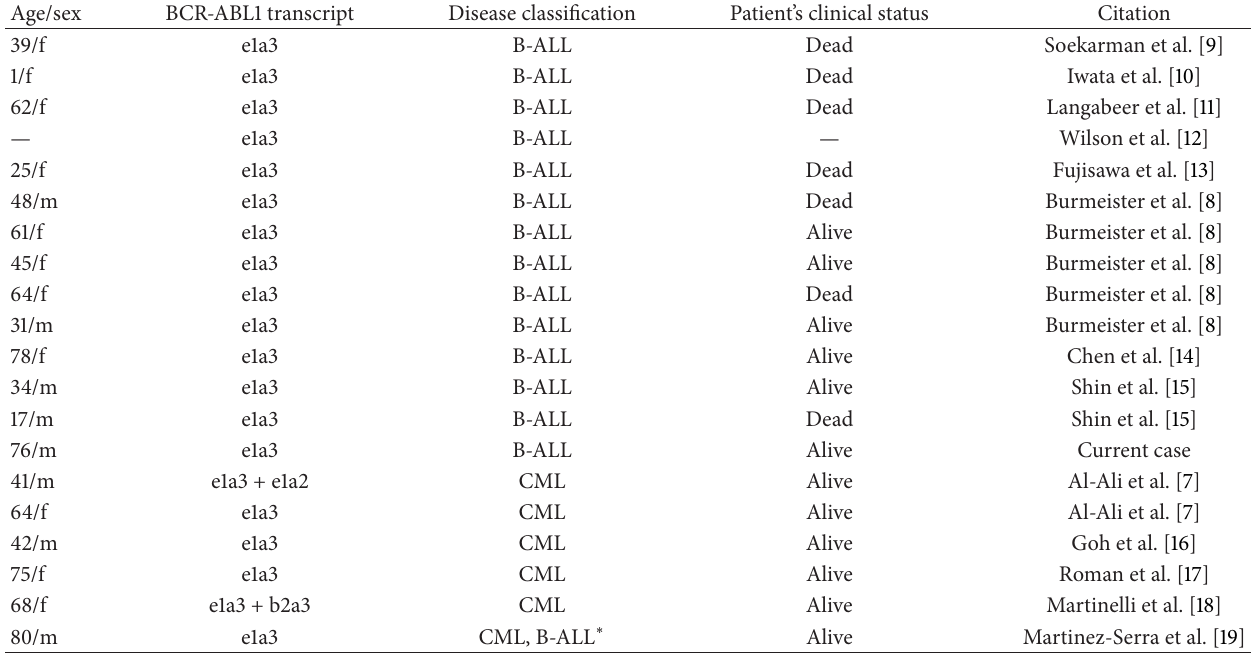
Table 1: Published cases of e1a3 fusion variants in BCR-ABL1 associated hematologic neoplasms [7–19].